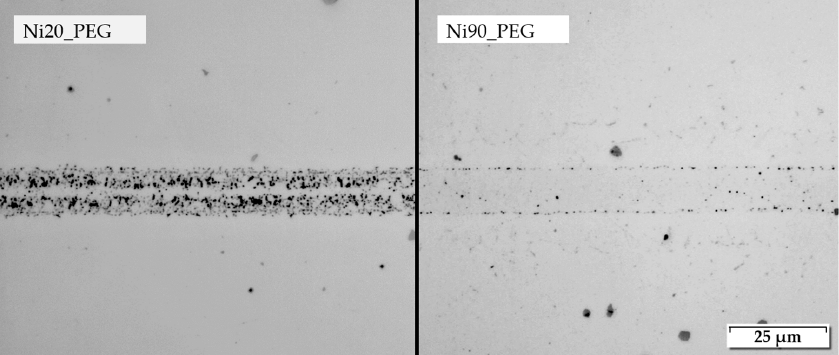
Figure 8. Microstructure of joining seams of IN 718_c using nanopastes Ni20_PEG and Ni90_PEG (joining temperature: 975 °C, holding time: 510 s (8.5 min), pressure: 23.3 MPa), light microscope. (joining temperature: 975 ◦ C, holding time: 510 s (8.5 min), pressure: 23.3 MPa), light